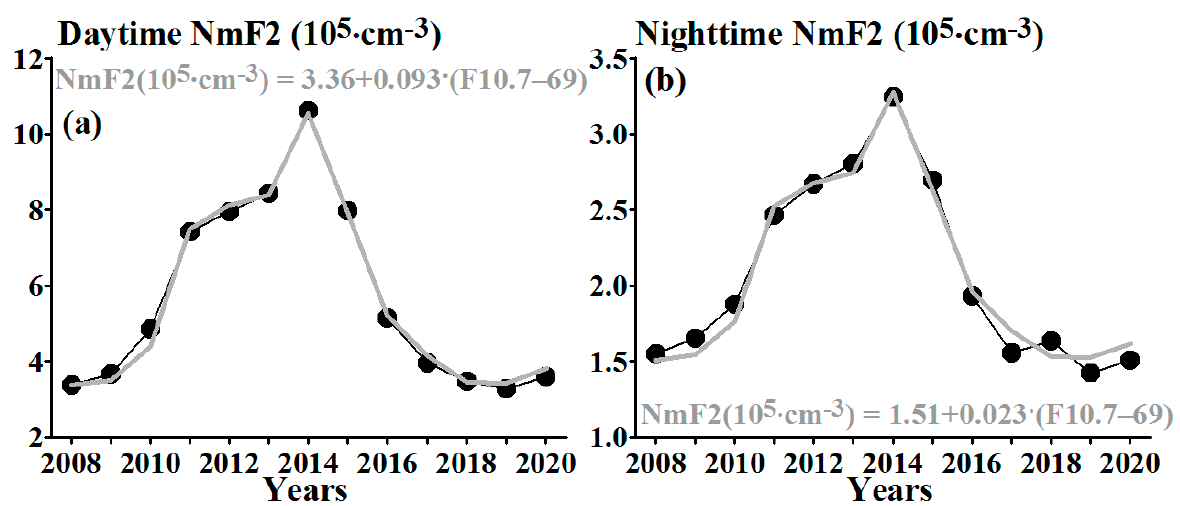
Figure 4. Year-to-year variations in the yearly average NmF2 (black circle line) and their approxi- mation by simple regression on F10.7 (grey) for the daytime ( left , a ) and nighttime ( right , b ).